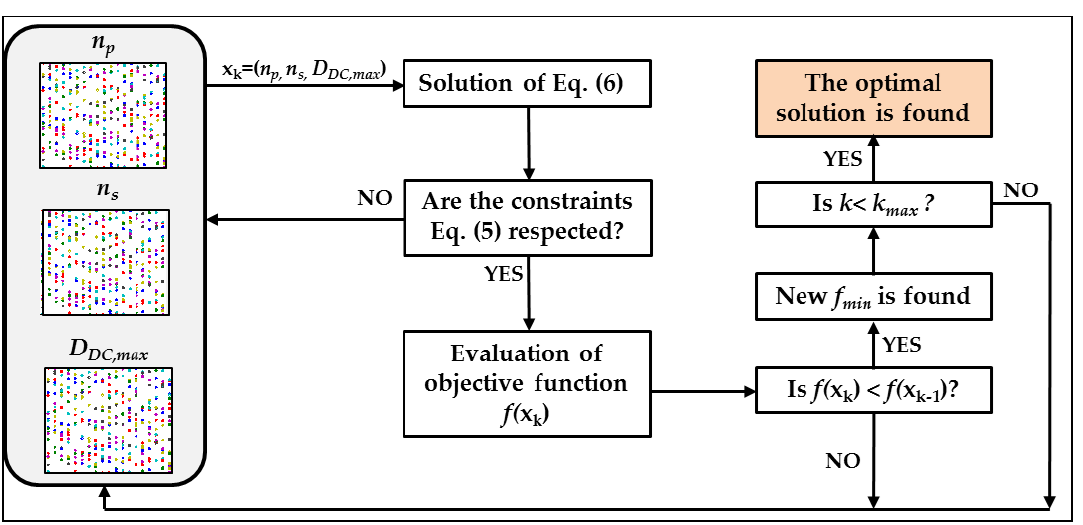
Figure 20. Random search algorithm adopted for the solution of the optimization problem.